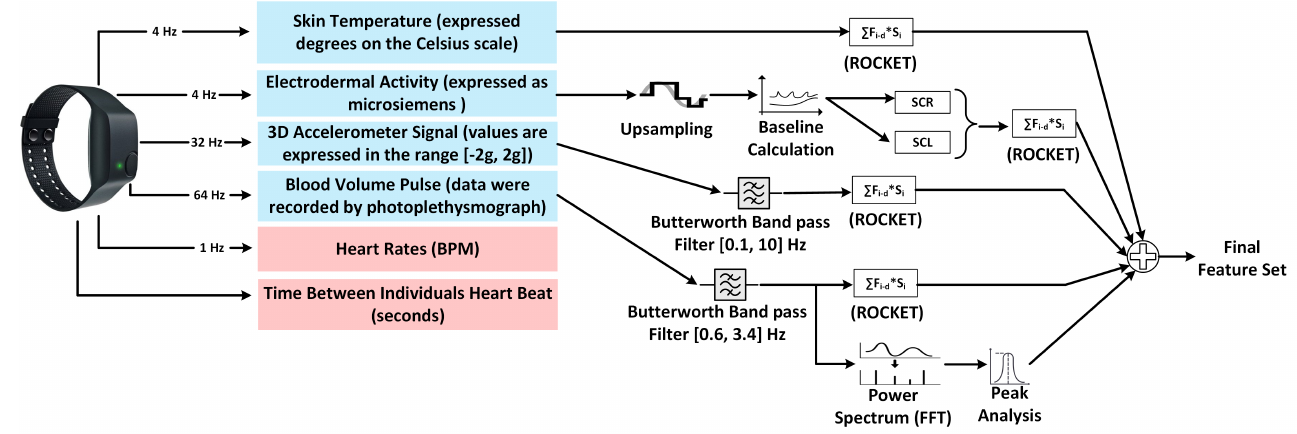
Figure 3. The signal processing pipeline for ROCKET feature